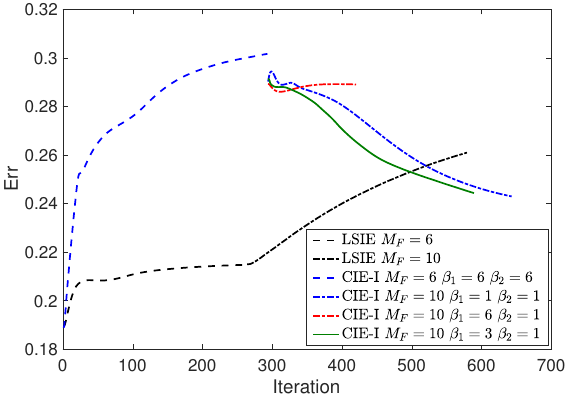
Figure 9. Errors of reconstructions obtained by different inversion methods for Example 2